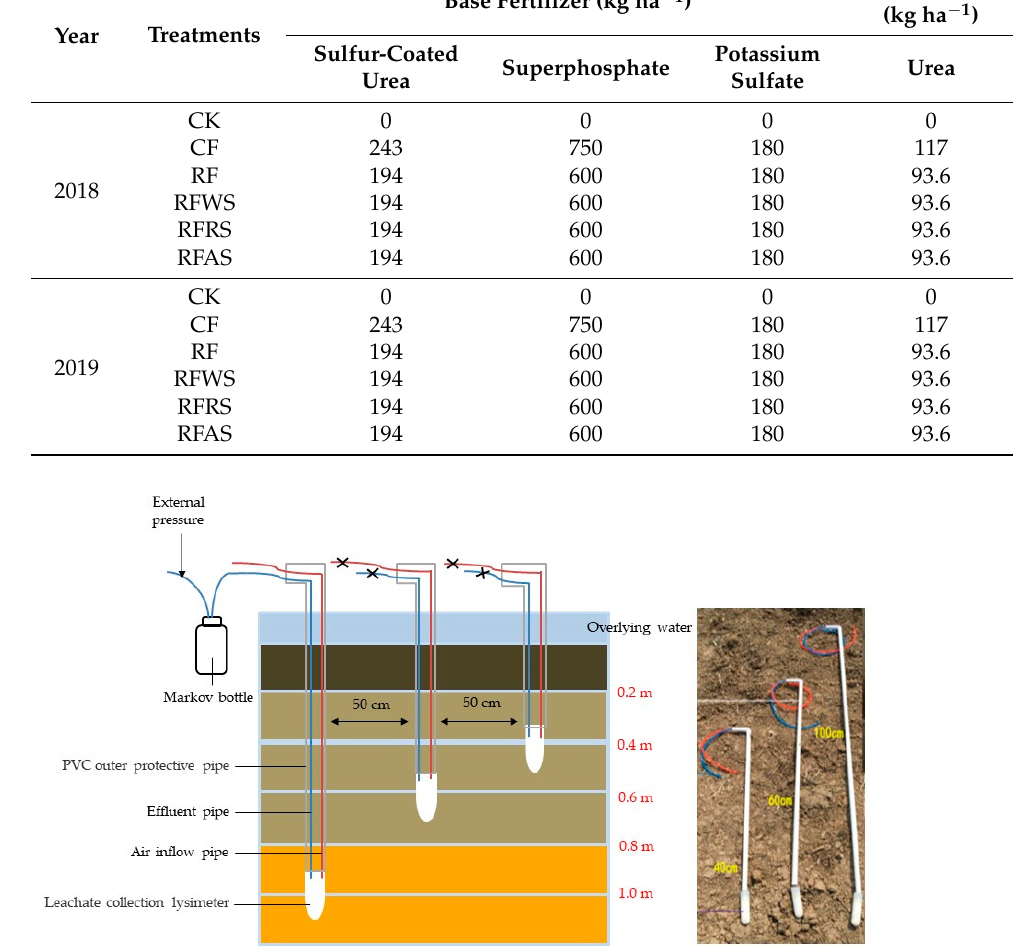
Figure 2. The collection device for leaching water in rice fields.